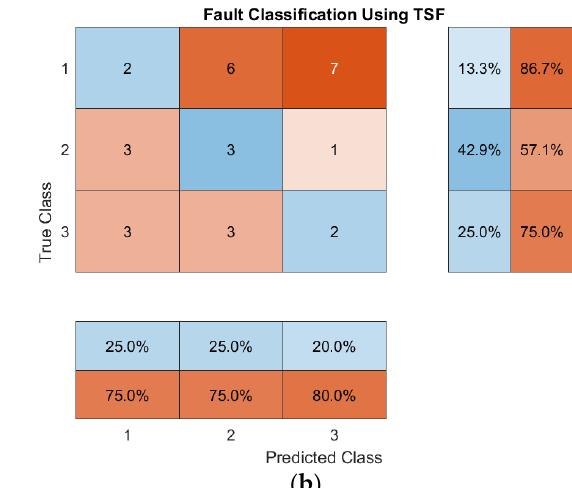
( b ) Figure 10. Confusion Matrix for LSTM Model: ( a ) Case 1; ( b ) Case 2. Table 10. LSTM Multivariate Performance. Average Accuracy